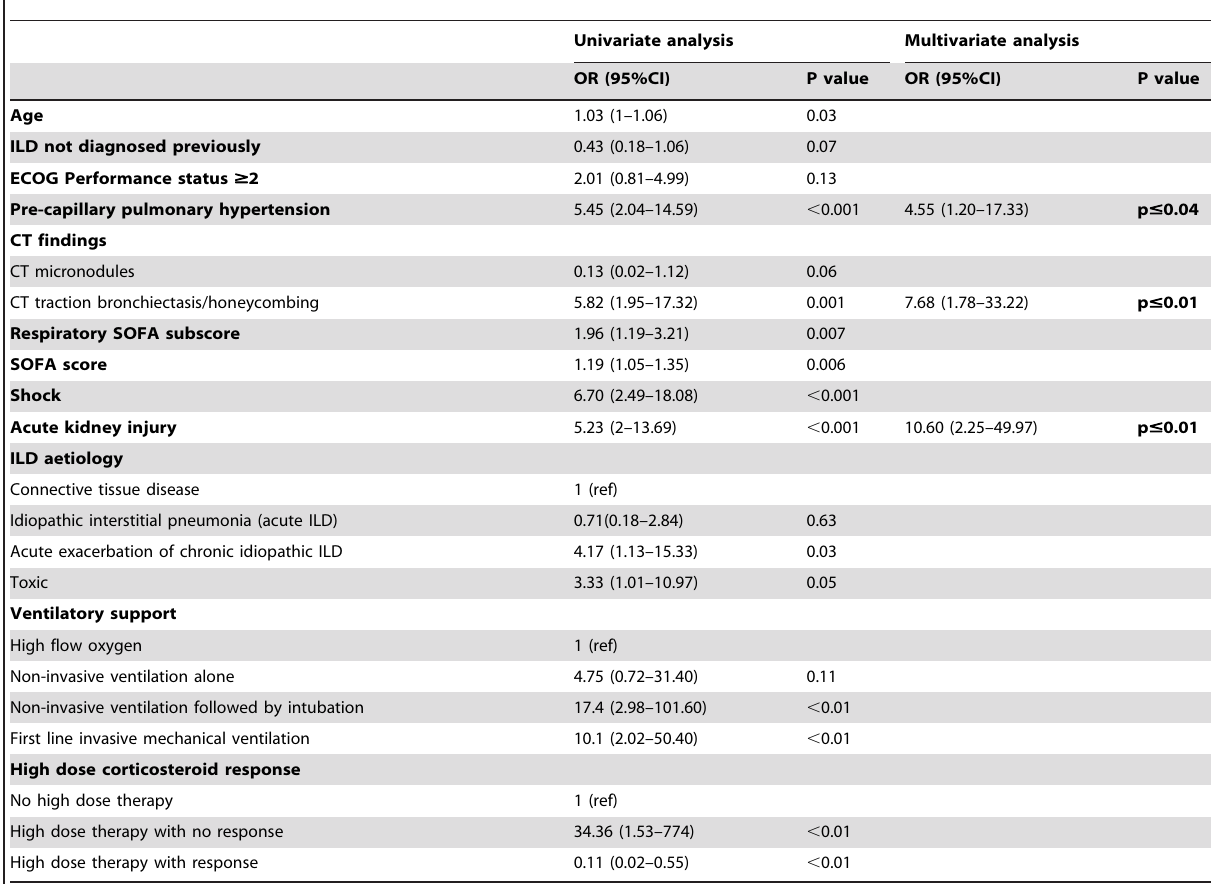
Table 4. Determinants of hospital mortality.